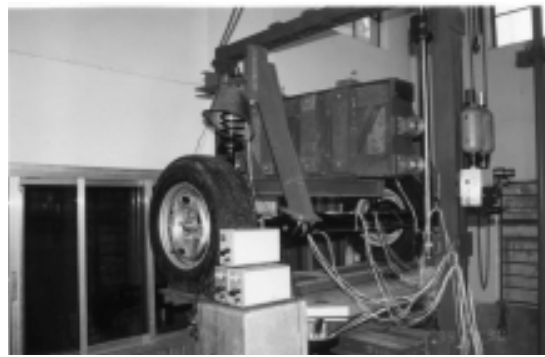
Fig. 5. The experimental set-up for bench tests of the rear dead axle, suspensions and absorbers.